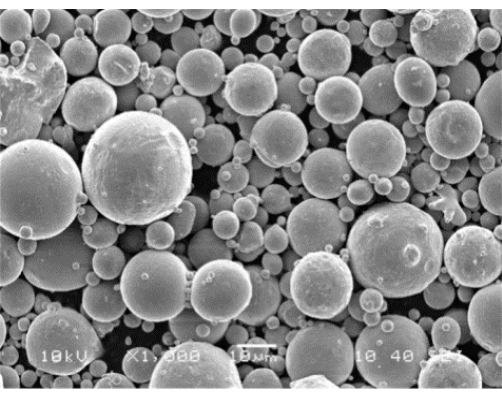
Figure 3. The SEM image of 316L stainless steel powder having the size of 500 mesh.